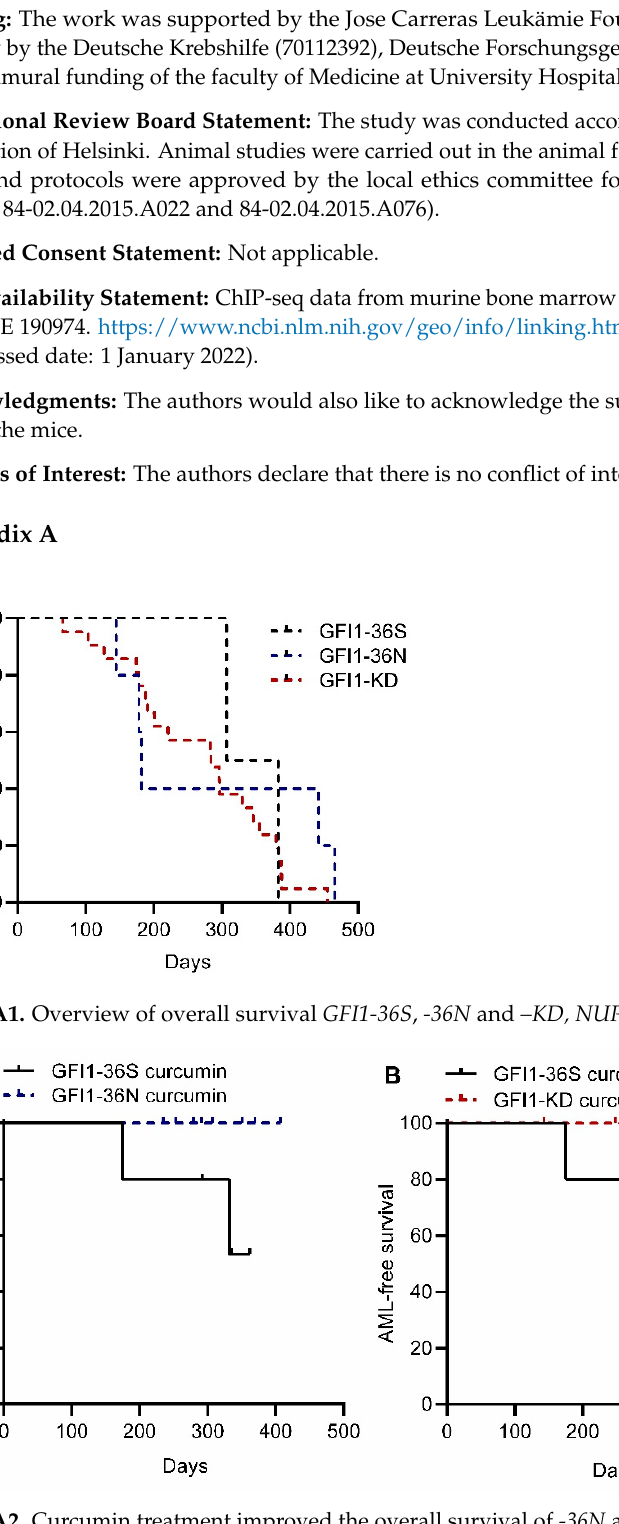
Figure A3. Curcumin treatment reduced leukemic blasts in GFI1-36N and -KD mice. ( A ) Frequency of leukemic blasts (Wright-Giemsa staining) in BM cytospins derived from GFI1-36S/-36N/-KD, NUP98/HOXD13-tg leukaemic mice (n = 4–7 per group). ( B ) Representative images in different groups. Scale bars represent 20 µm respectively.